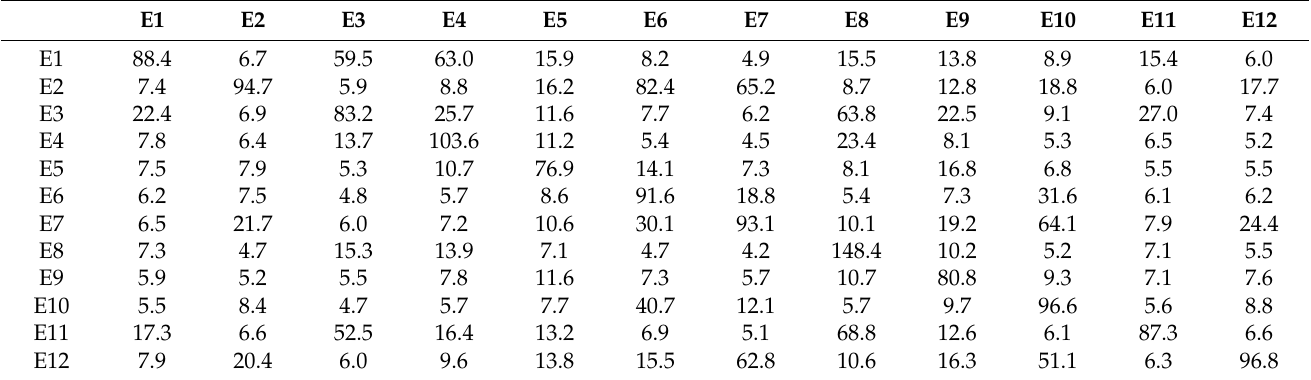
Table 3. Thermal radiation intensity ( KW/m 2 ) of element i to element j without spray system.